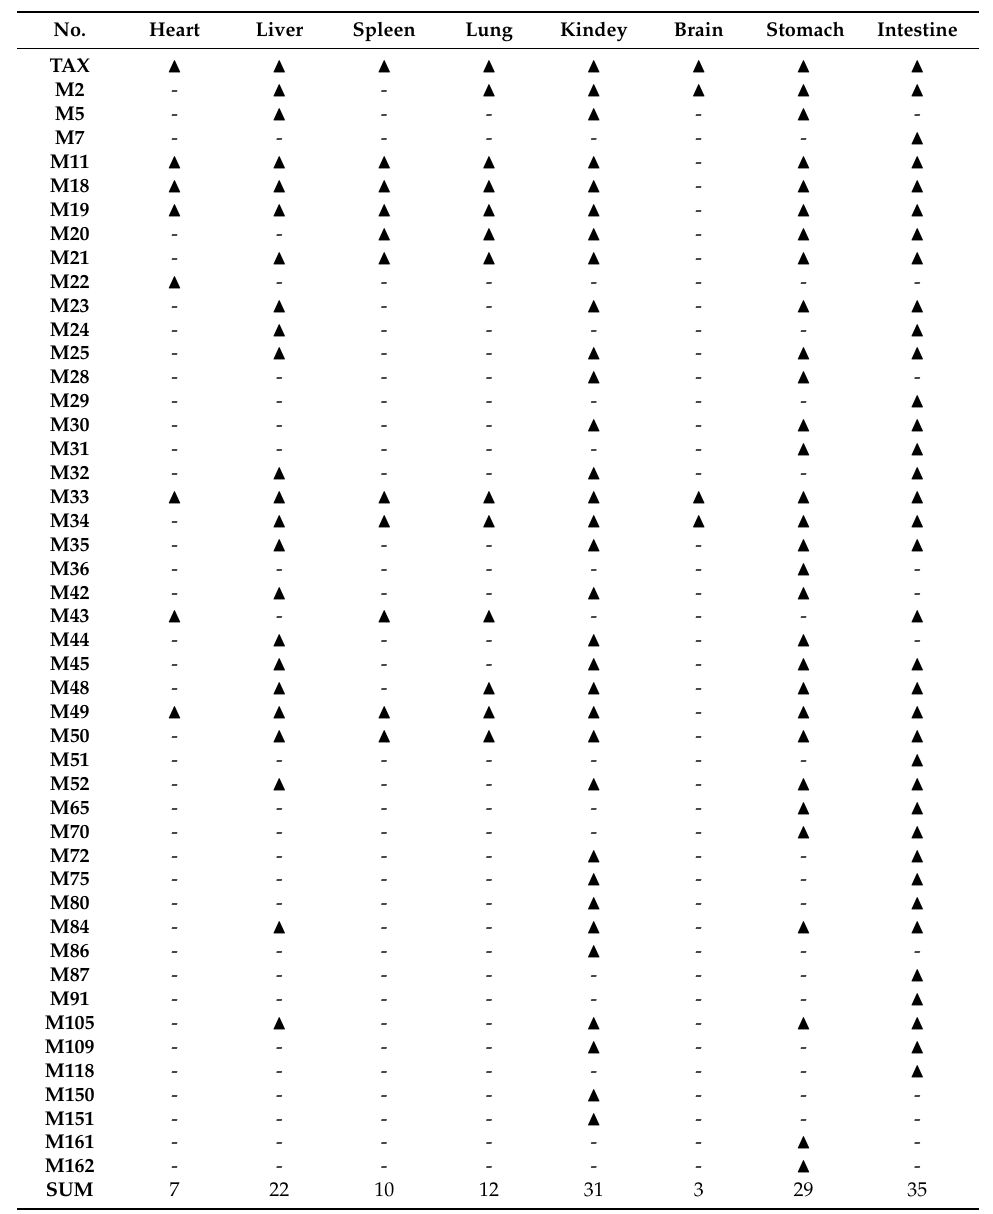
Table 3. Distribution of taxifolin and its 46 metabolites in